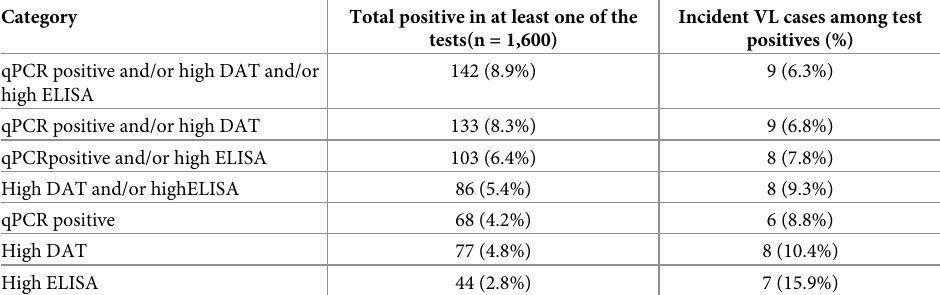
Table 1. Numbers of subjects that tested positive at baseline to at least one test- at high cut-off, in several combi- nations of tests (n = 1,600) and numbers of VL cases that developed among those. Category